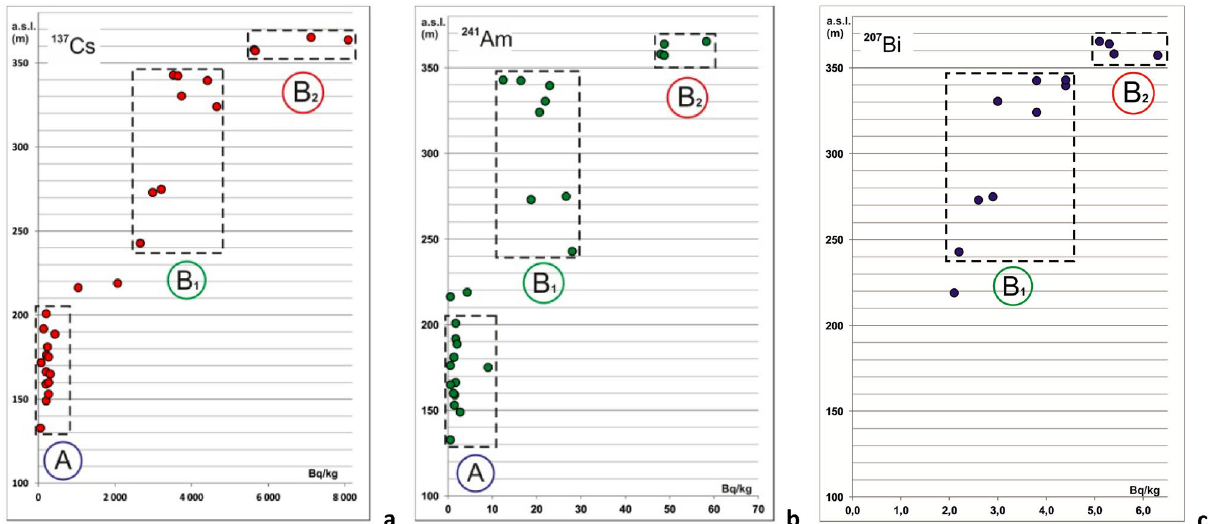
Figure 4. Distribution of the specific activity of anthropogenic radionuclides in cryoconite as a function of altitude on the surface of the Nalli Glacier: ( a )—A Cs-137 (m a.s.l.); ( b )—A Am-241 (m a.s.l.); ( c )—A Bi-207 (m